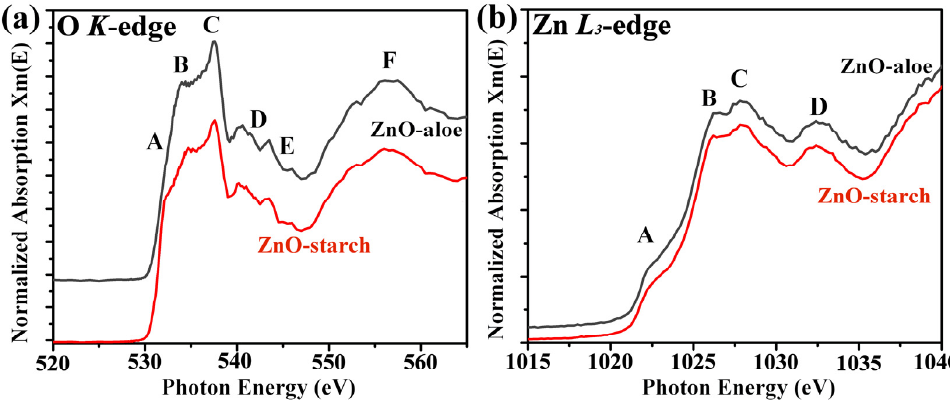
Figure 3. Normalized spectra of ( a ) O K -edge and ( b ) Zn L 3 -edge NEXAFS spectra of ZnO-aloe and ZnO-starch samples.